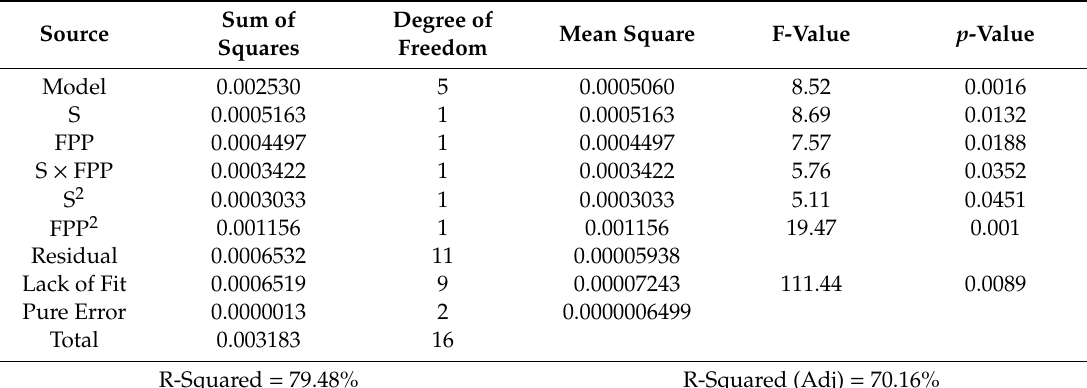
Table 7. ANOVA table of the ratio of top to bottom